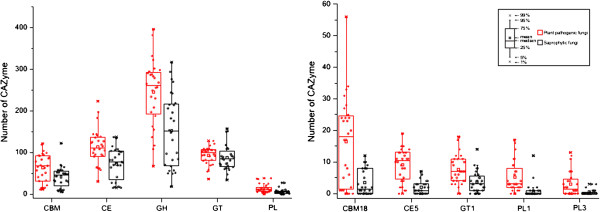
Comparison of CAZymes between saprophytic fungi and plant pathogenic fungi. (A) The number of members in each CAZyme class and CBM in the predicted proteomes were plotted for plant pathogenic fungi (red dots) and saprophytic fungi (black dots). (B) The number of CAZymes which showed obvious differentiation supported by t test among plant pathogenic fungi and saprophytic fungi.